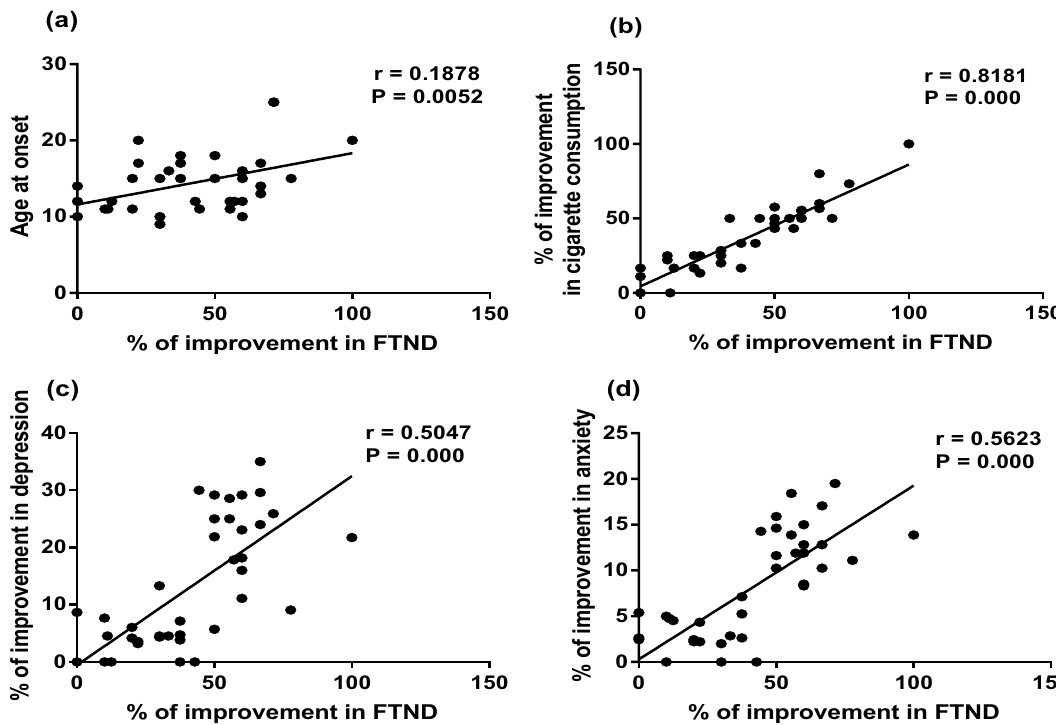
Figure 2. Correlations between percent of improvement in FTND and duration of smoking, percent of improvement in cigarette consumption, depression and anxiety. Subjects with a longer history of smoking had a significantly lower percent improvement in FTND (r = 0.187 and p = 0.005; ( a )). The percentage reduction in cigarette consumption also correlated significantly with the percent change in FTND (r = 0.881, and p = 0.0001; ( b )). Significant correlations between percent improvement in FTND and percent improvement in both HAM-D and HAM-A were found (r = 0.504 and p = 0.0001, and r = 0.562, and p = 0.0001 respectively; ( c , d )). Error bars denote the standard deviation